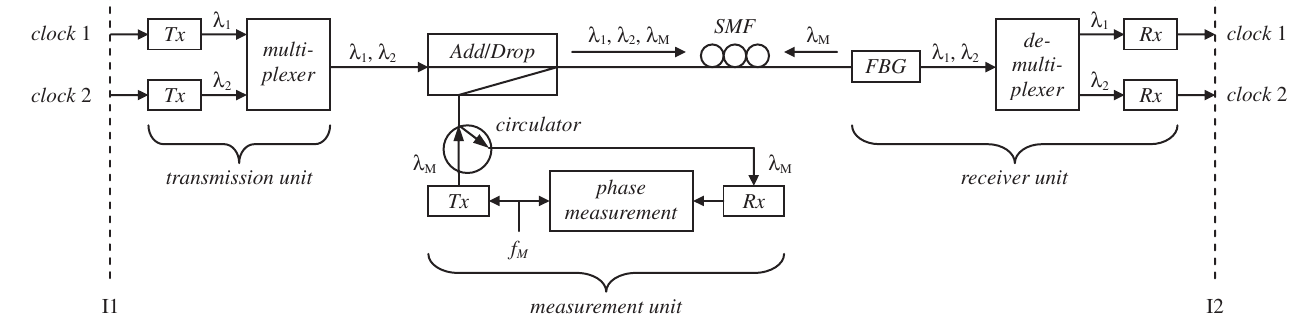
FIG. 6. Configuration of one transmission branch with transmission and measurement